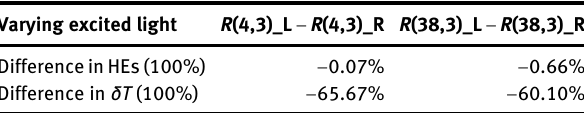
Table  : HE generation rate and temperature increase of R (  ,  ) and R (  , 